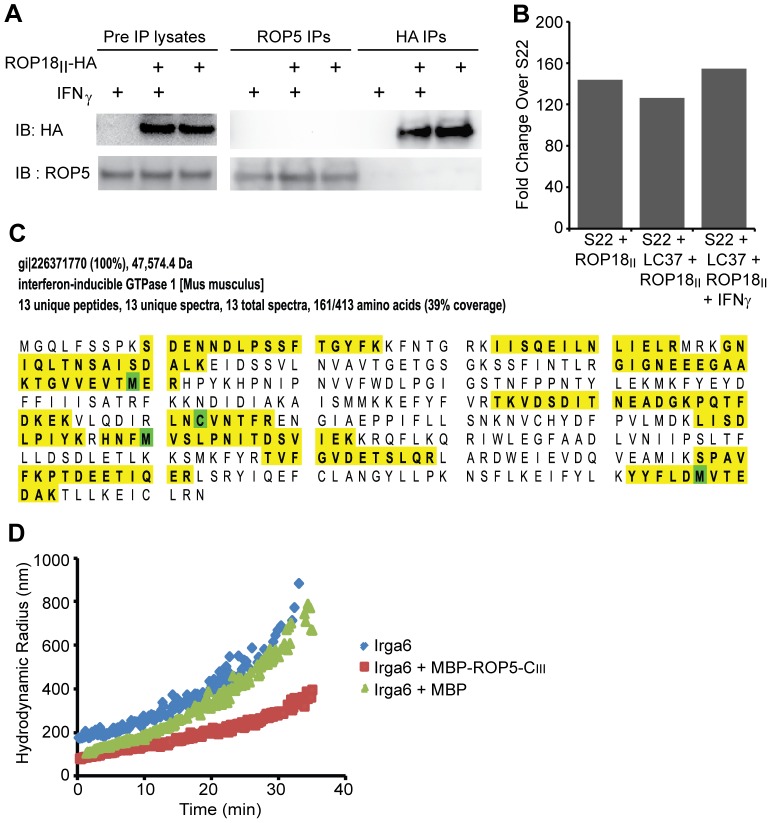
ROP5 interacts with Irga6, but not ROP18, and inhibits Irg6 oligomerization.(A) ROP5 and HA were immunoprecipitated from IFNγ-stimulated or unstimulated MEFs infected with CEP or CEP + ROP18II-HA and inputs and immunoprecipitates were Western blotted for ROP5 and HA. (B) Kinase activity of ROP18-HA immunoprecipitated from IFNγ-stimulated or unstimulated MEFs infected with S22, S22 + ROP18II-HA or S22 + LC37 + ROP18II-HA parasite strains. Half of the immunoprecipitated protein was Western blotted with anti-HA and the relative amount of ROP18-HA from each strain was quantified using the ImageQuant (GE Healthcare Life Sciences) software. The remaining immunoprecipitated proteins were incubated with 32P-γ-ATP and a model peptide substrate (Lim, D., submitted) and spotted in quadruplicate onto phospho-cellulose paper where the 32P-γ-ATP incorporation was quantified by phosphorimage analysis. The kinase activity is expressed as fold change over the S22 strain and normalized to the relative amounts of ROP18-HA that was immunoprecipitated. This experiment was performed twice and the graph represents the mean from those experiments. (C) Unique peptides (yellow) and percent sequence coverage of Irga6 recovered from mass spectrometry of proteins co-immunoprecipitated with ROP5-CIII-HA. Briefly, HA-immunoprecipitated proteins from IFNγ-stimulated or unstimulated MEFs infected with Pru, Pru + ROP5-AIII-HA, Pru + ROP5-CIII-HA or RH + GRA15II-HA and lysed in the presence or absence of 0.5 mM GTPγS were separated by SDS-PAGE and analyzed by MS/MS. Irga6 peptides were recovered only in ROP5-CIII-HA samples lysed in the presence of GTPγS. (D) Oligomerization of 20 µM Irga6 with10 mM GTP at 37°C in the presence of MBP-tagged ROP5-C or MBP shown as predicted mean hydrodynamic radius of the particle population determined by dynamic light scattering.